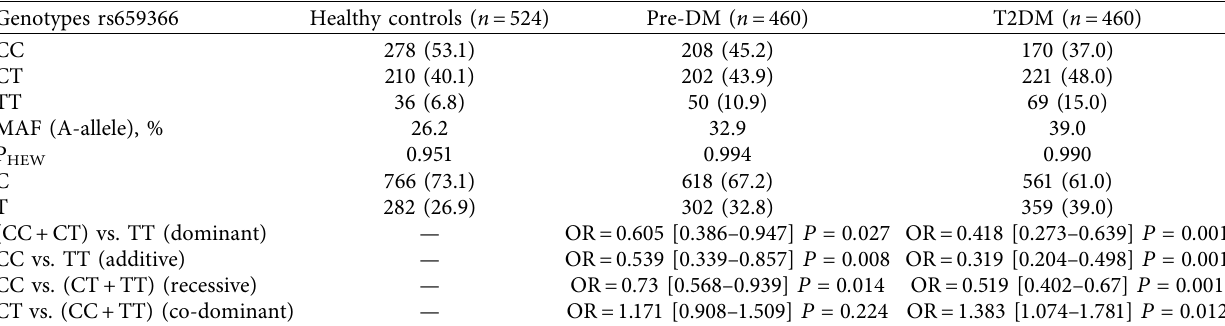
Table 2: Genotype and allele frequencies for the ANGPTL 8 rs2278426 (C/T) polymorphism in the study groups. Genotypes rs659366